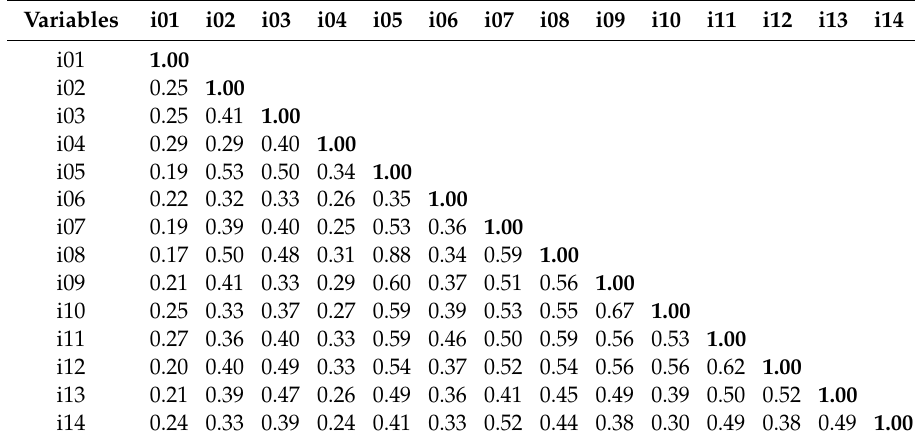
Table 7. Pearson coe ffi cient correlation.